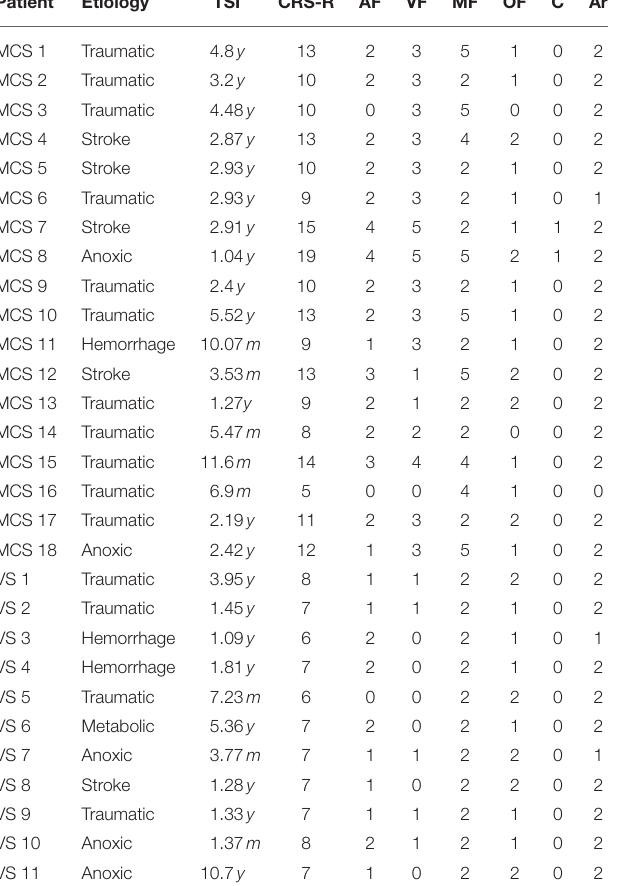
6.98, p = 0.01] between B phases (treatment) and A phases (no treatment); CRS-R total scores being higher during treatment. However, when considering the diagnosis, CRS-R total scores were found to be higher during treatment in MCS patients [ F (1) = 7.18, p = 0.01] but not in VS patients [ F = 1.28, p = 0.27] (1) ( Figure 1 ). Regarding subscores, higher scores during treatment (B phases vs. A phases) were only found for the oromotor subscale ( T = 2.73, p = 0.006) and the arousal subscale ( T = 2.8, p = 0.005). Such difference was confirmed in MCS patients ( T = 2.07, p = 0.04 and T = 2.22, p = 0.03, respectively) but not in VS patients ( Table 2 ).